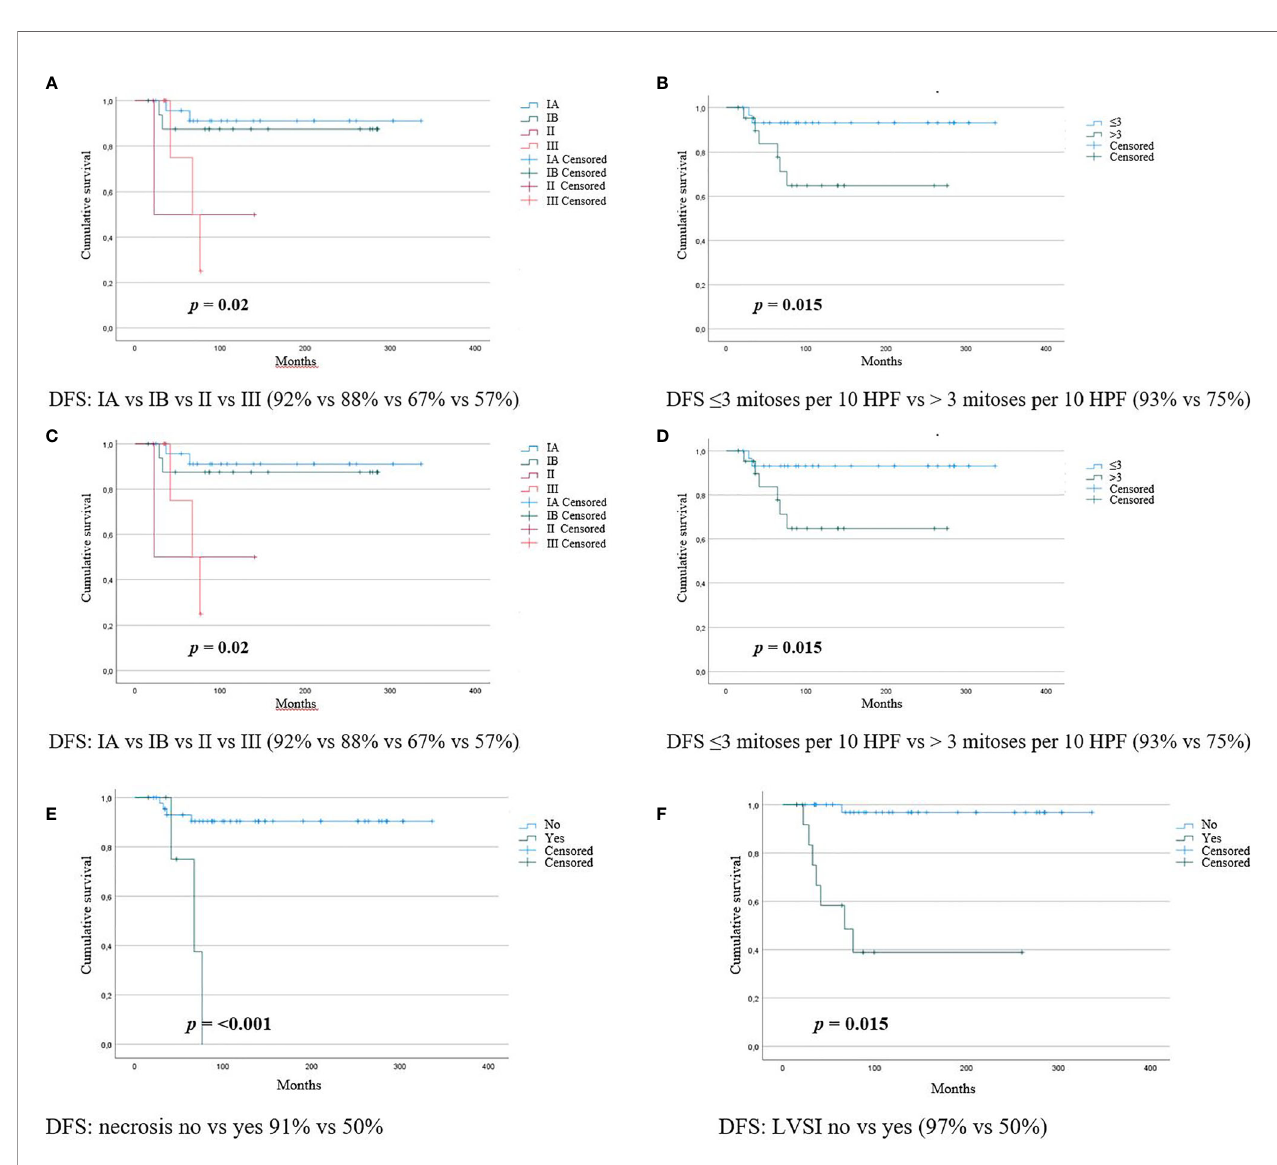
FIGURE 1 | Kaplan-Meier curves for LG-ESS recurrences according to (A) morcellation (B) tumor size (C) FIGO stage (D) mitotic count (E) necrosis (F)